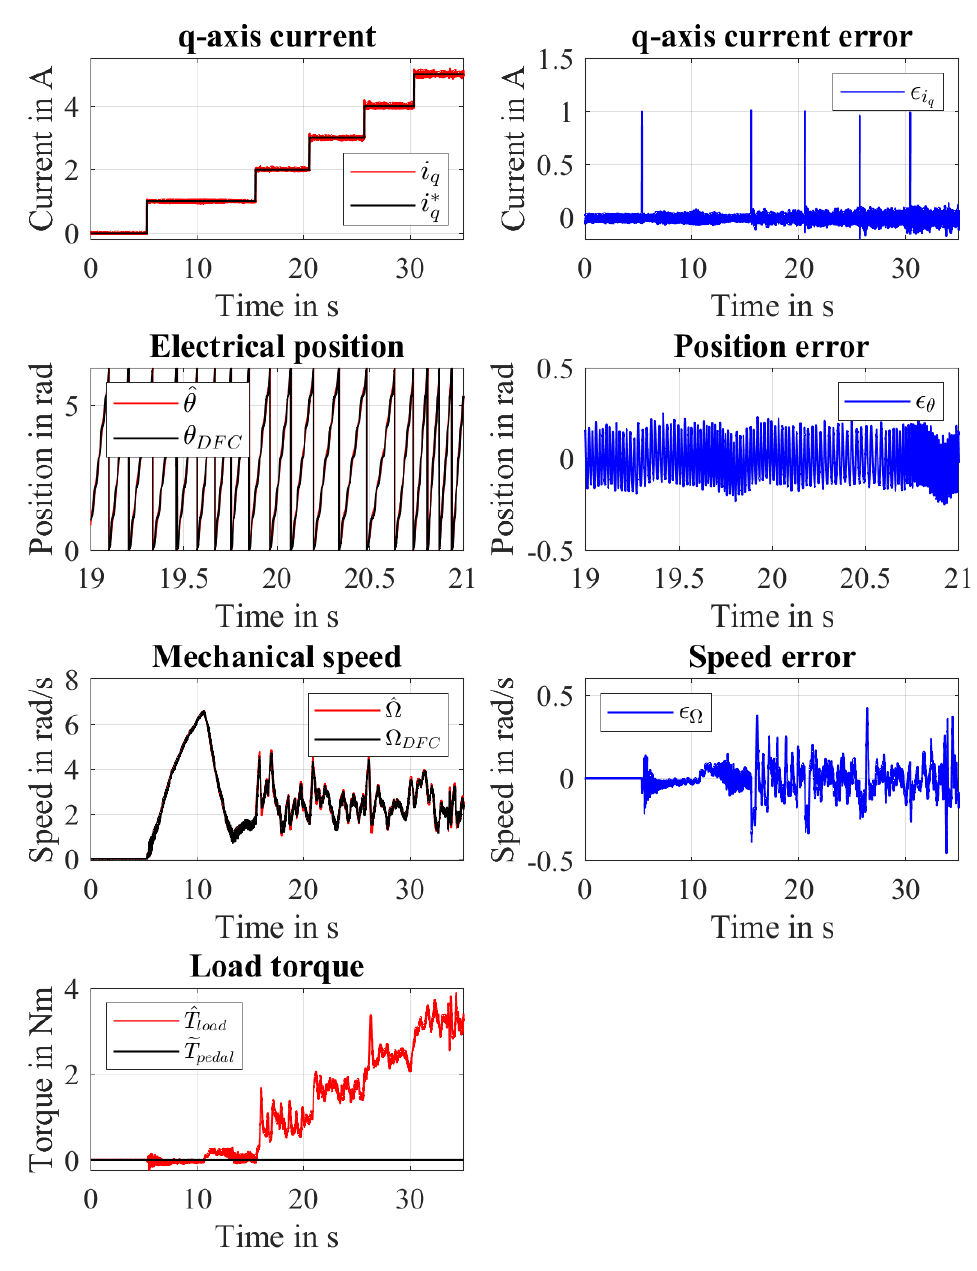
Figure 11. Experiment E2 : Torque control with an applied external torque